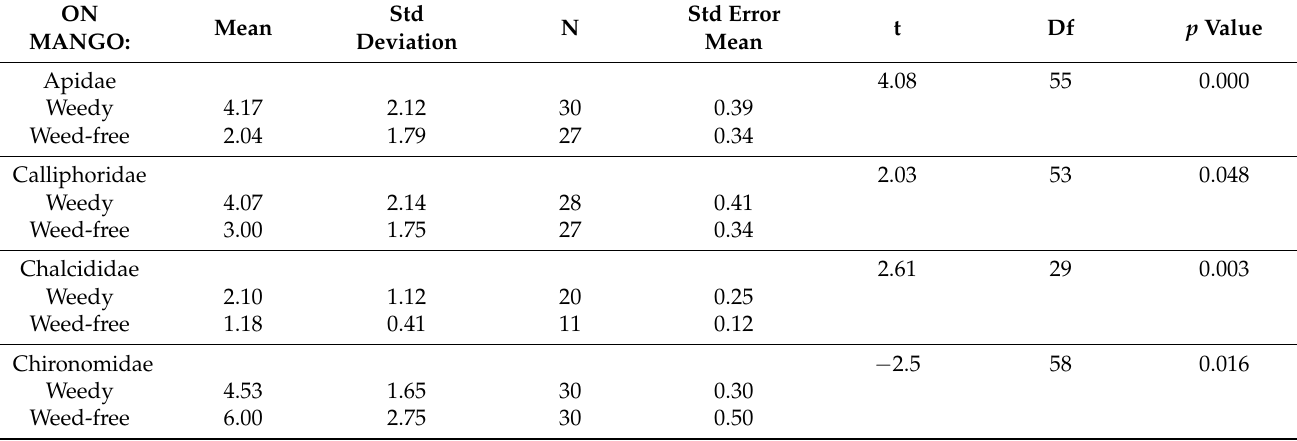
Table 3. Insect families on mango that show significant differences in numbers on mango trees growing with/without weeds in Homestead, Florida,